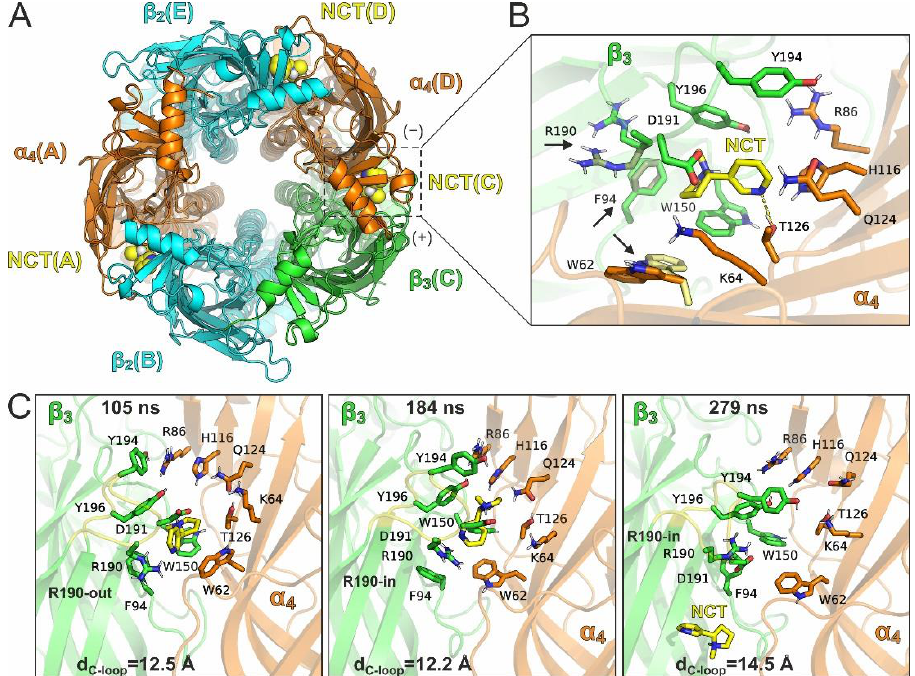
Figure 5. ( A ) Top view of the pentameric α4/β2/β3/α4/β2 assembly with a third nicotine molecule bound at the β3(+)/α4(– ) interface (lipids and solvent are omitted for clarity). Subunits are color- coded as in Figure 2 and chain IDs are indicated in parentheses. ( B ) Close-up view of the agonist binding site illustrating the initial bound conformation of nicotine (NCT), which was taken by su- perposition of the nicotine- bound α4 subunit after modifying the side chain conformation of Arg190 away from the potential agonist- binding site of β3. Three starting models were employed in MD simulations by varying the initial conformation of the interacting residues that are indicated with arrows. ( C ) Snapshots from an MD trajectory illustrating nicotine dissociation from the β3(+)/α4(−) interface. These snapshots are representative structures (centroids of clusters) that were obtained by clustering of MD frames between 50 and 300 ns of the simulation (Figure S8, Supplementary Mate- rial). The close-up views illustrate only the interacting residues shown in the initial bound pose ( B ), indicating the simulation time, the state of Arg190 with respect to β3 agonist -binding site and the loop C distance (d C-loop ) of β3(+)/α4(−) .